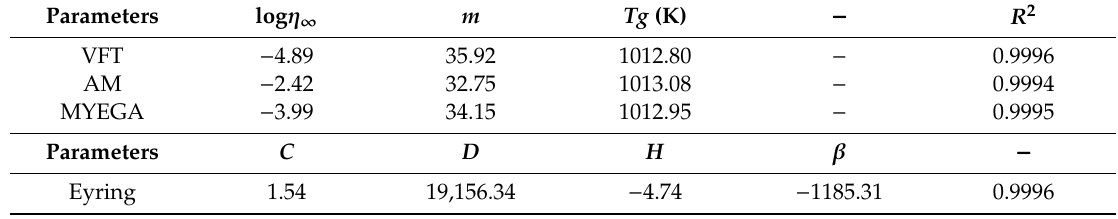
Table 2. Obtained parameters of 7.9Cs 2 O-23.2CaO-66.7SiO 2 -1Fe 2 O 3 in the modified Eyring model and R 2 .